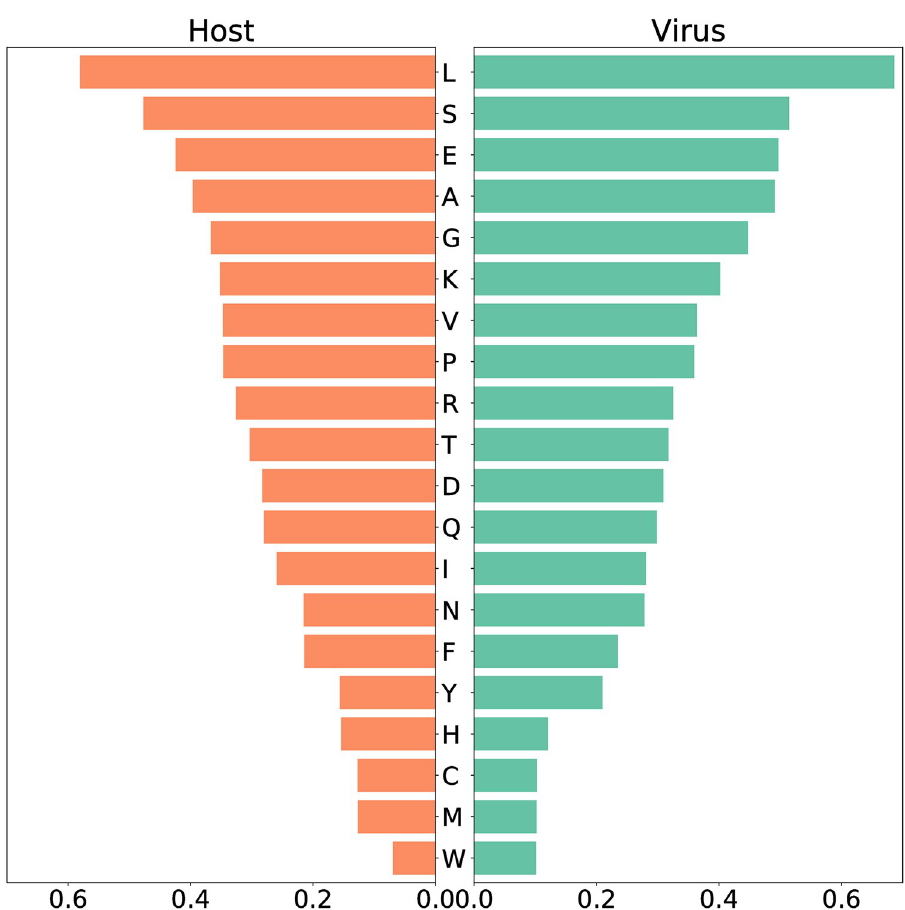
Fig 4. Amino acid usage between host and virus based on the stoichiometric coefficients. The two panels show the amino acid composition of the host maintenance function (left) and the virus biomass (right). The amino acids are annotated using the one-letter code (S6 Table). Both host and virus use mostly leucine ( L ) for their maintenance/ growth, while tryptophan ( W ) is needed at least. The same amount of asparagine ( N ) and phenylalanine ( F ) is required for the maintenance of the host cell, while the virus needs less phenylalanine. Similar pattern can be observed for tyrosine ( Y ) and histidine ( H ).